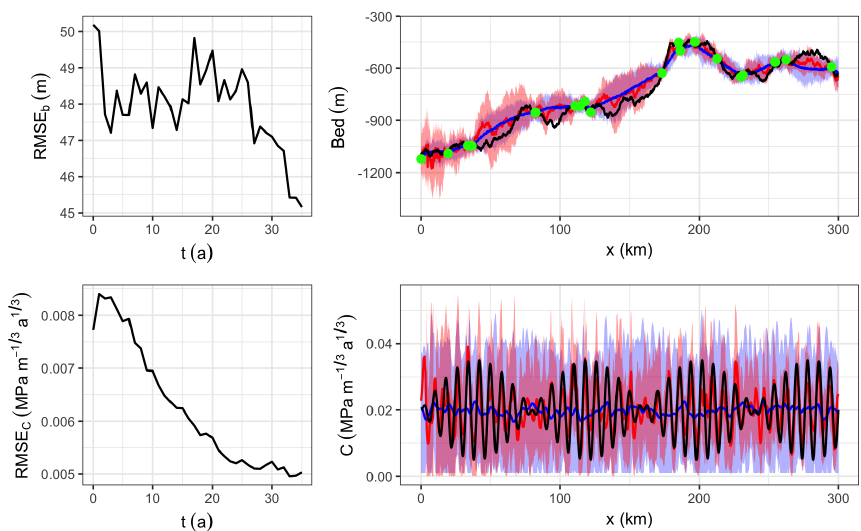
Figure 8. Same as Fig. 3 but with the RMSE computed for x ∈ [ 0 , 300 ] km.